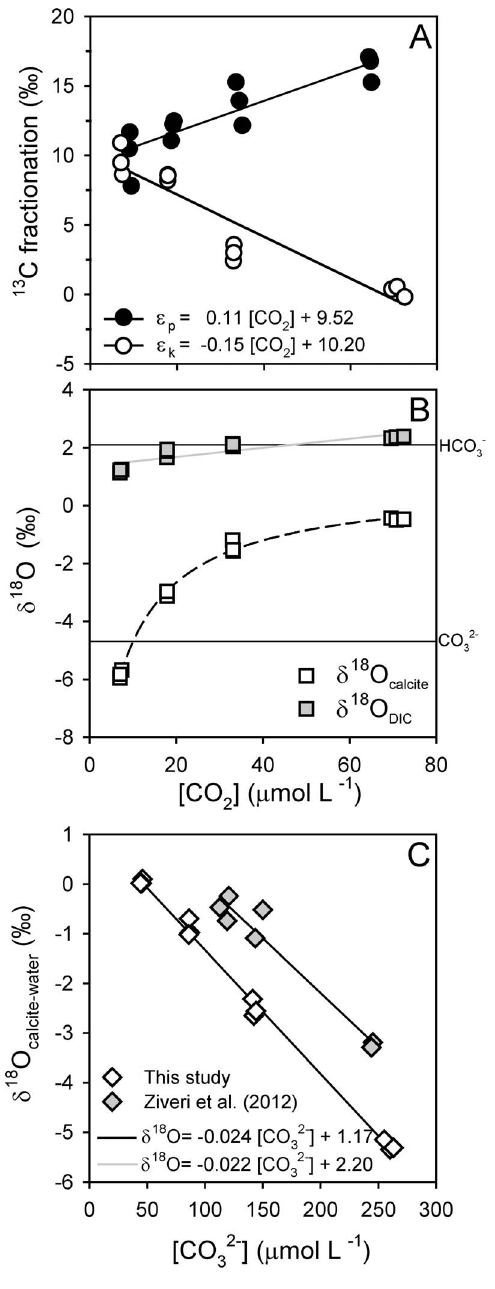
Figure 3. Effect of increasing CO 2 concentrations on the stable isotope composition. (A) 13 C fractionation of organic carbon ( e p ) and calcite ( e k ), (B) 18 O composition of calcite ( d 18 O calcite ) and DIC ( d 18 O DIC ), and (C) relationship between the oxygen isotopic composition of calcite ( d 18 O calcite-water ) in Thoracosphaera from this study (open diamonds) and from Ziveri et al. [9] (grey diamonds). Horizontal lines in (B) indicate d 18 O values for HCO 3 2 and CO 32 2 , and dashed line indicates trend of curve. Solid lines indicate linear regressions ( n =12) with (A) e p : R 2 =0.75, P , 0.001, and e k : R 2 =0.90, P , 0.001, (B) d 18 O DIC : R 2 =0.76, P , 0.001, and (C) This study: R 2 =0.99, P , 0.001, and Ziveri et al. (2012), ( n =7): R 2 =0.95, P , 0.001.